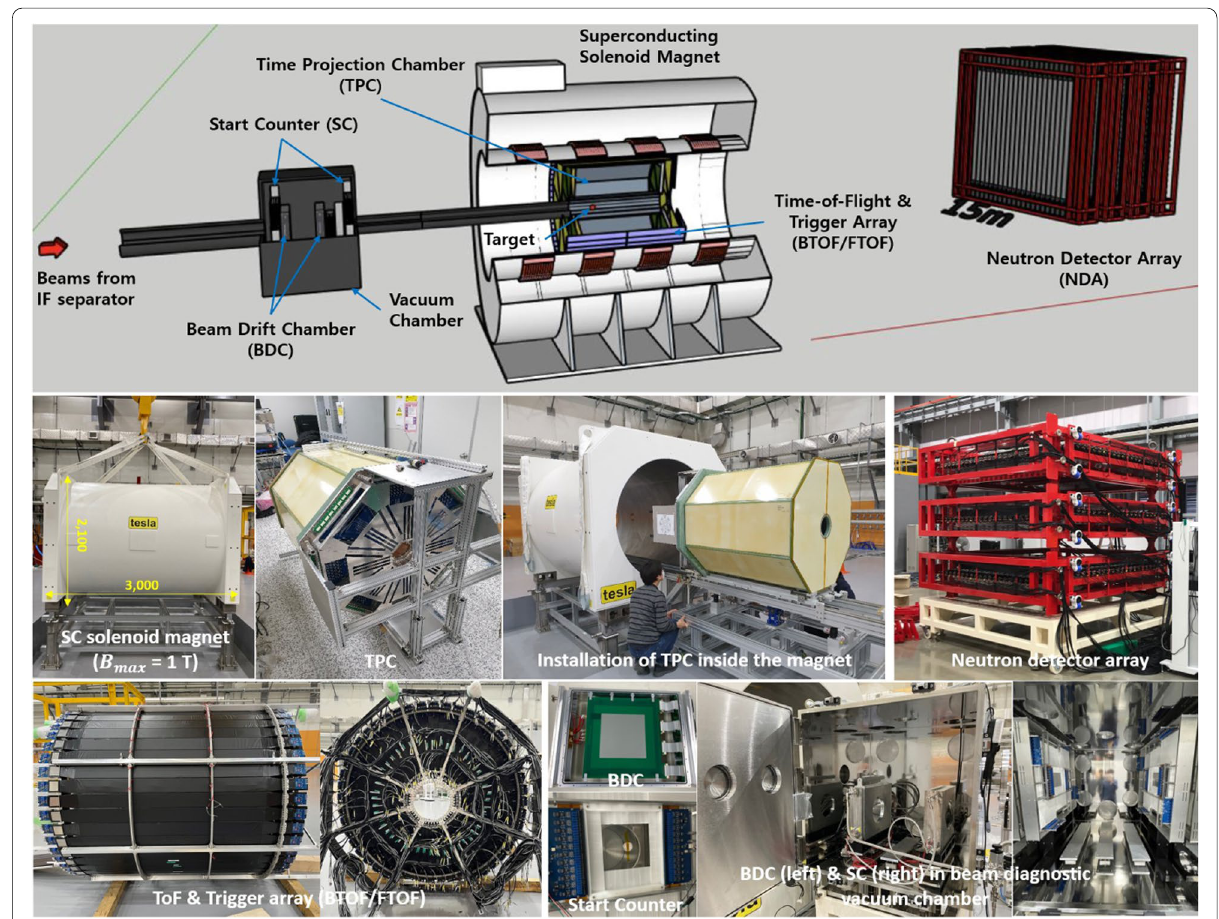
Fig. 15 Schematic of LAMPS. The ion beams from IF are transported to the LAMPS from the left. The middle row shows the images of the superconducting solenoid magnet, TPC, installation of TPC in the magnet, and the forward neutron detector array. The bottom row shows the BToF, FToF, BDC, and SC, and the image of the beam diagnostic vacuum chamber after BDC and SC is